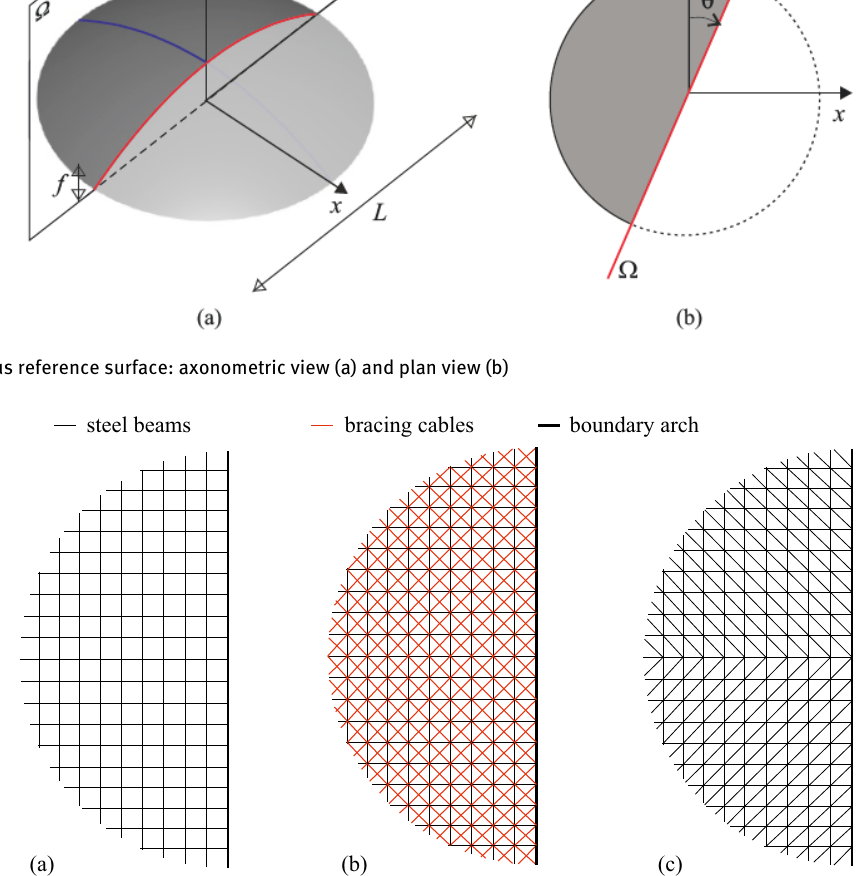
Figure 3: Gridshell layouts: quadrangular (a), hybrid (b) and triangular